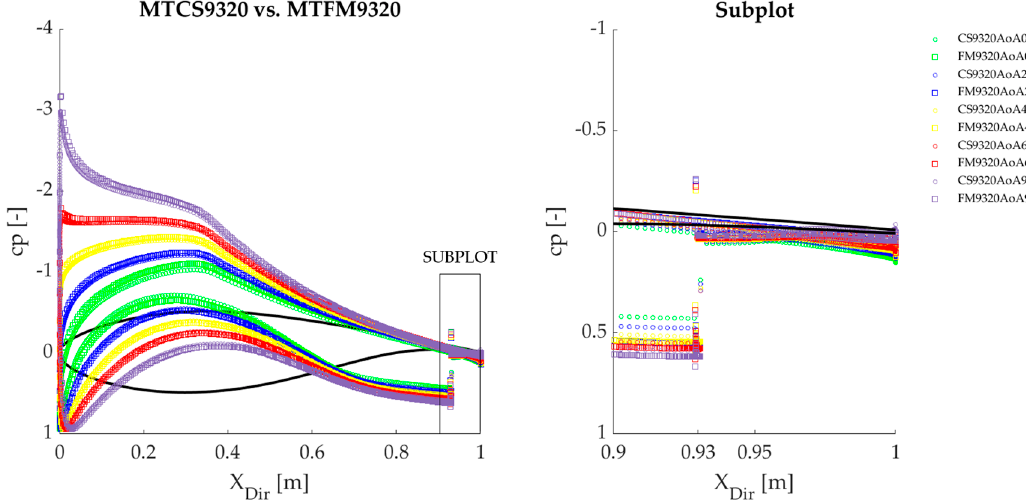
Figure 8. Pressure distribution of the DU91W(2)250_MTCS9320 and DU91W(2)250_MTFM9320 cases represented with the pressure coefficient (cp) at AoA = 0°, 2°, 4°, 6° and 9°. The subplot shows an enlarged view of the MT area.